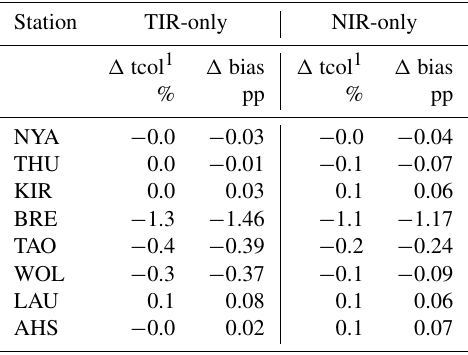
Table C3. Difference between original profile validation and profile filling techniques (V6 TIR-only and